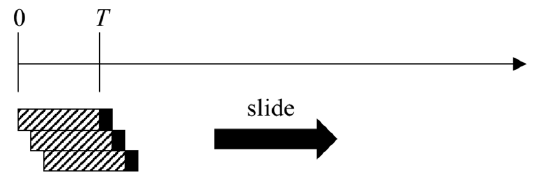
Figure 3. The traditional identification scheme.